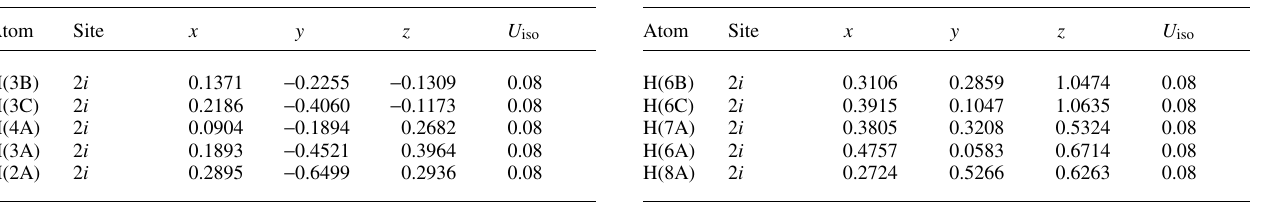
Table 2. Atomic coordinates and displacement parameters (in Å 2 ) .